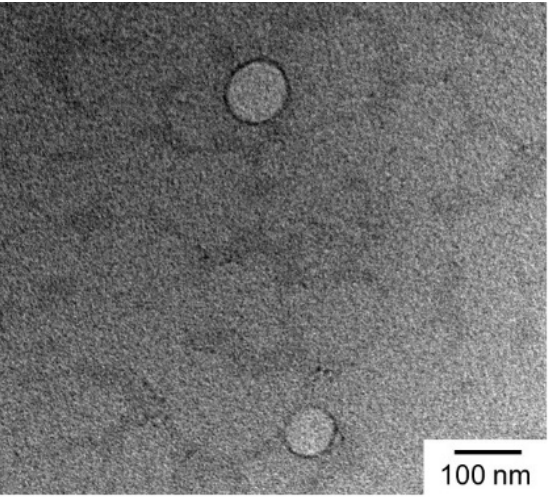
Figure 5. Transmission electron microscopy image of PG 500 prepared via dispersion polymerization with PVA 500 .